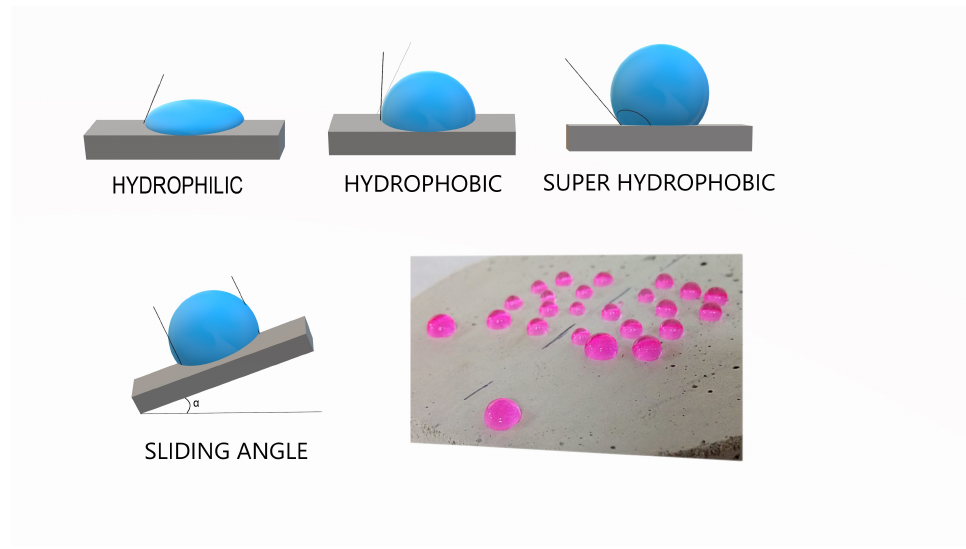
Figure 1. Contact angle and Sliding angle on the